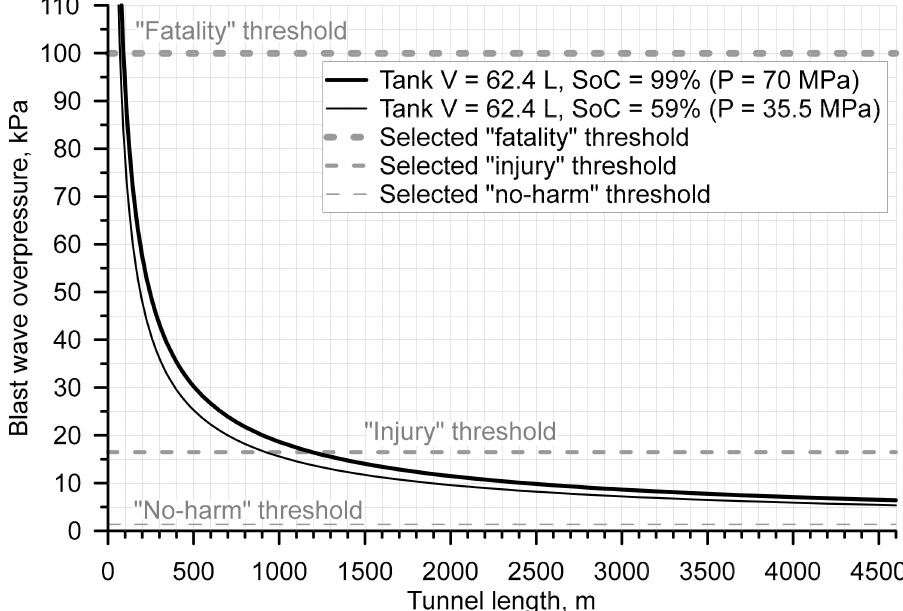
Figure 3. Blast wave decay in the Dublin Tunnel for the 62.4 L tank for SoC = 99% and SoC = 59% (T = 20 ◦